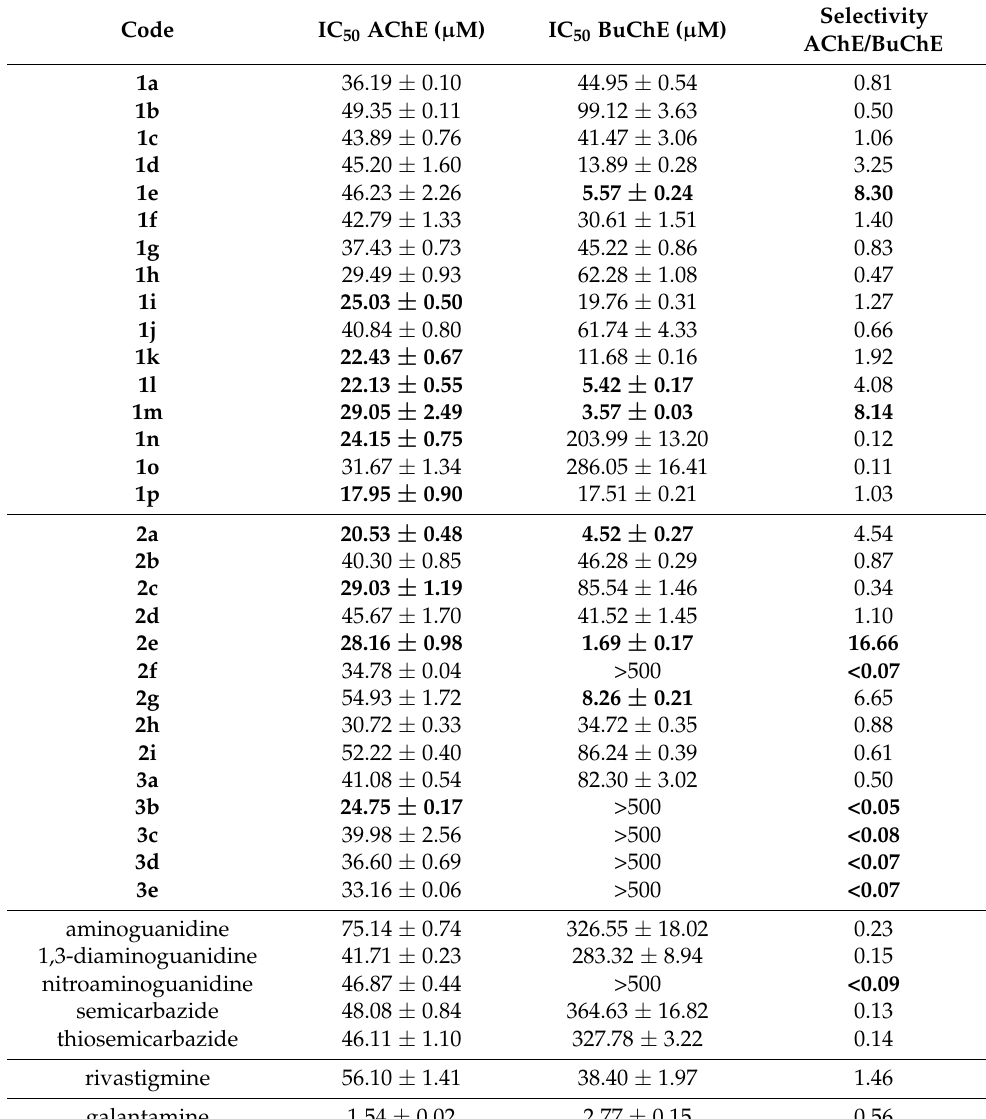
Table 3. Inhibition of AChE and BuChE and selectivity indexes of 1 – 3